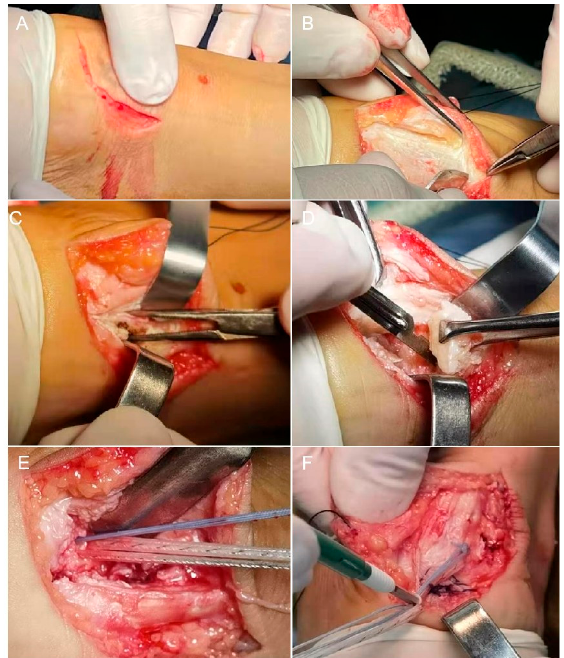
Figure 1. Intraoperative photographs of internal bracing. ( A ) Surgical incision. ( B ) The Achilles tendon was exposed. ( C ) Splitting the Achilles tendon through the midline. ( D ) Resection of the calcific lesion and the posterior bursa of the Achilles tendon. ( E ) Implantation of the medial row screw. ( F ) Implantation of the lateral row screw.